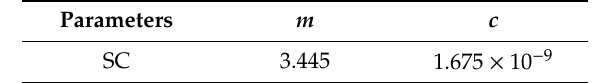
Table 5. Material parameters in the Paris equations of the single crack specimen.